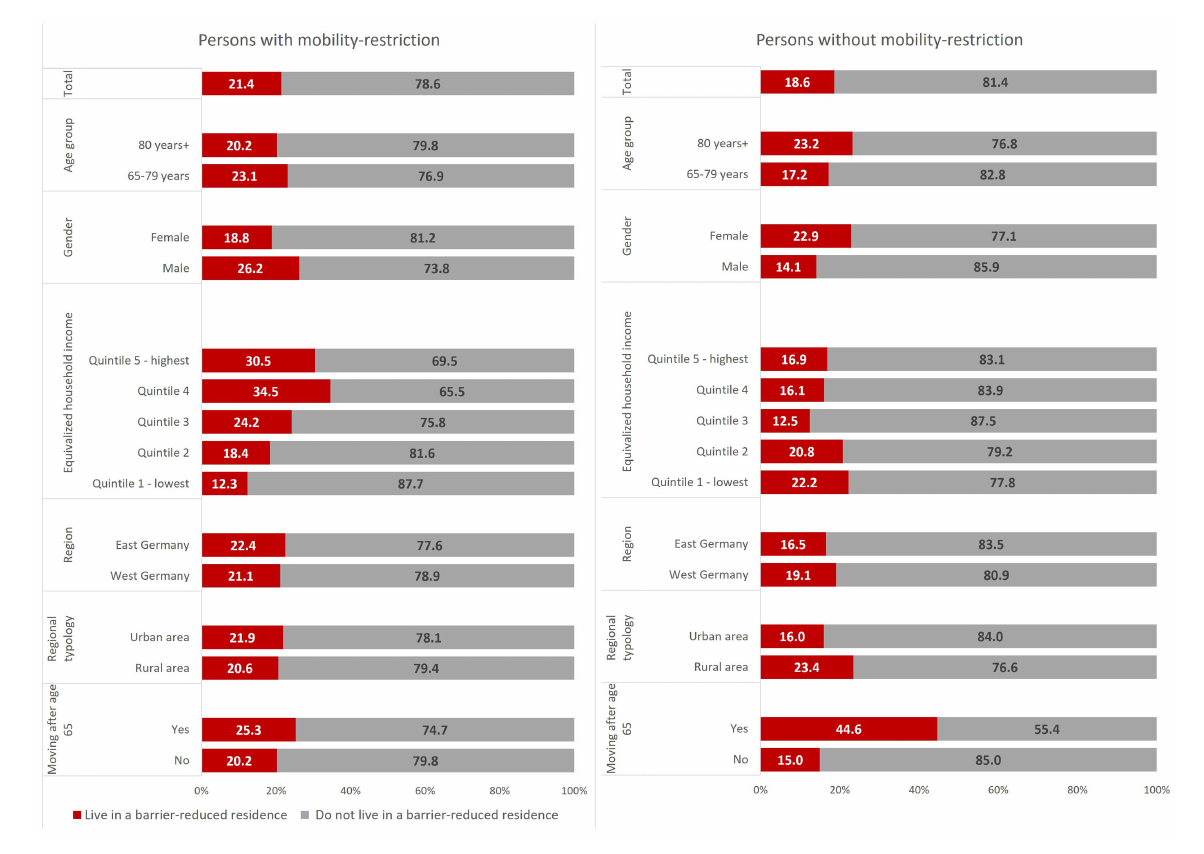
FIGURE 1 Proportions of persons with or without mobility-restriction who (do not) live in a barrier-reduced residence (%). Source: DEAS 2020/21 ( n = 2,800). Weighted